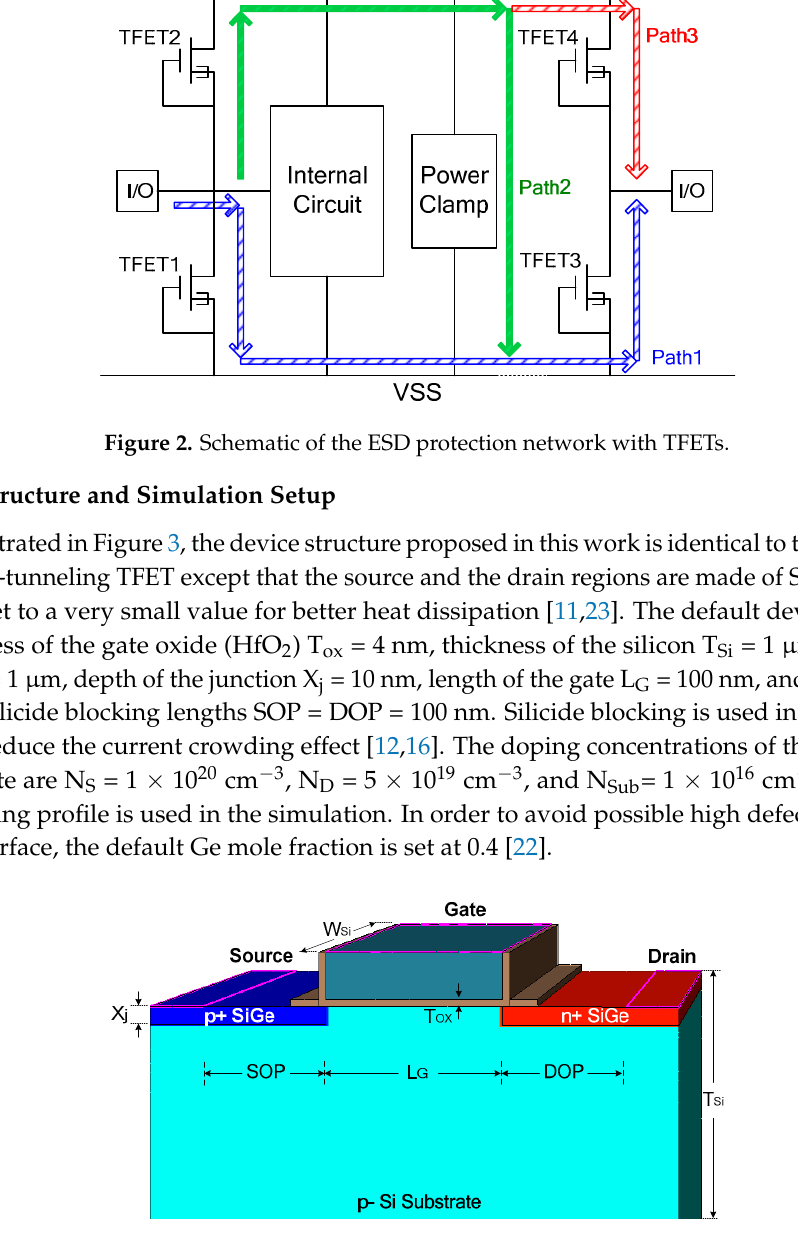
Figure 3. Schematic of the proposed SiGe source/drain (S/D) TFET.